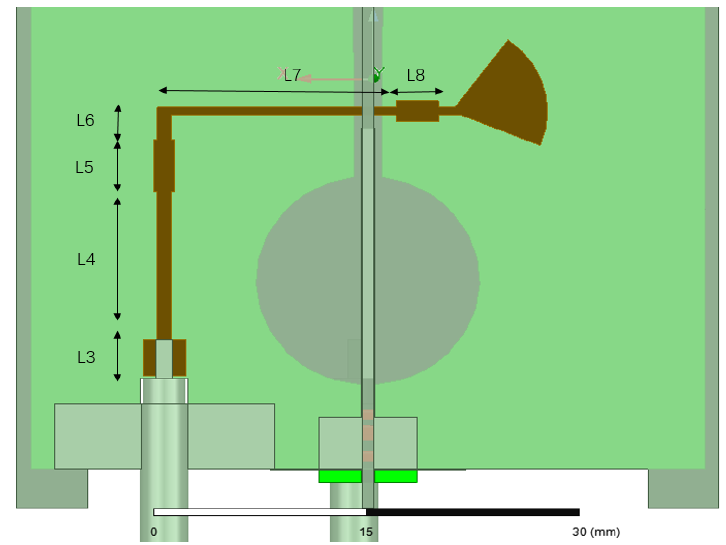
Figure 3. Broadband feed